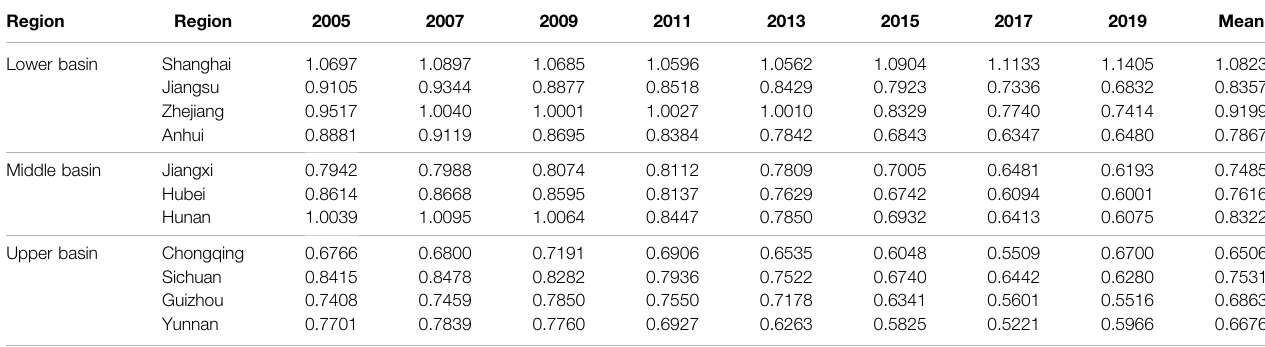
TABLE 3 | Regional GFFPs in the CEA.